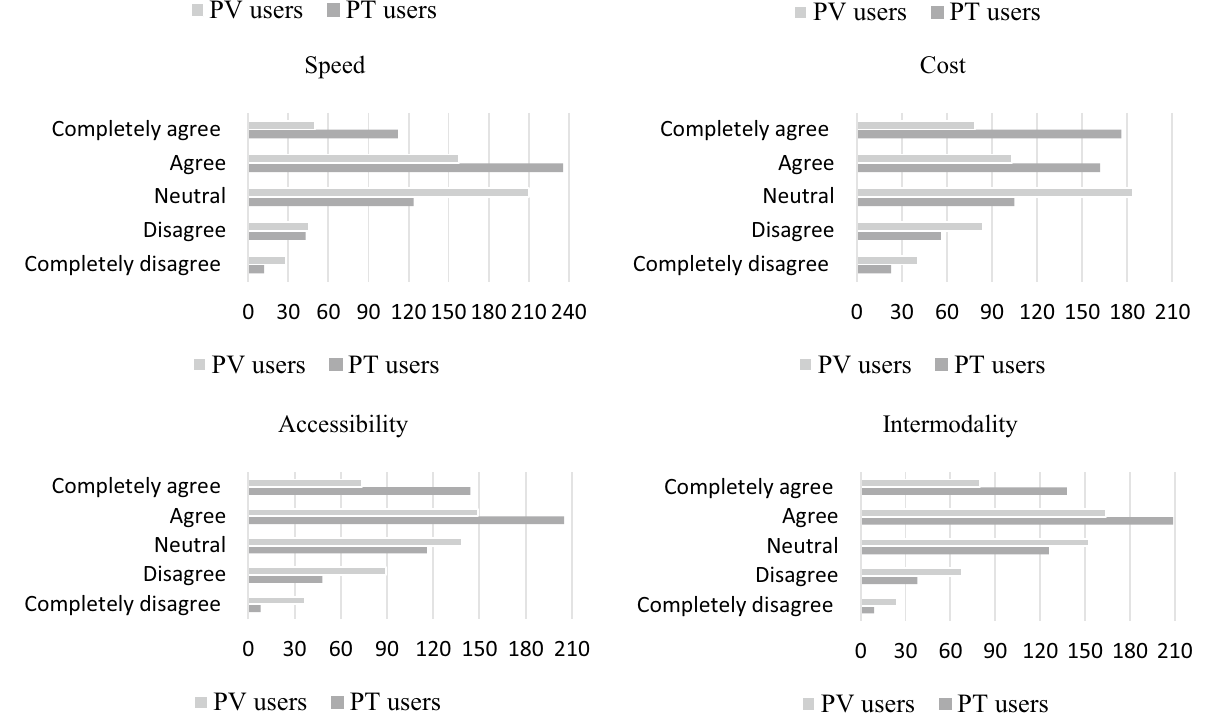
Fig. 4 Frequency score distributions of th03030e PT and PV users’